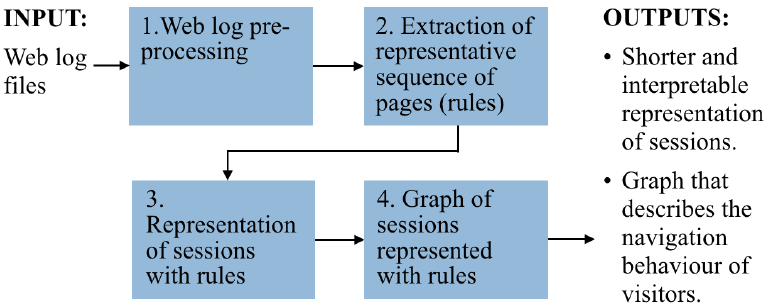
Figure 1. The four-step methodology for characterizing website visitors based on their navigation